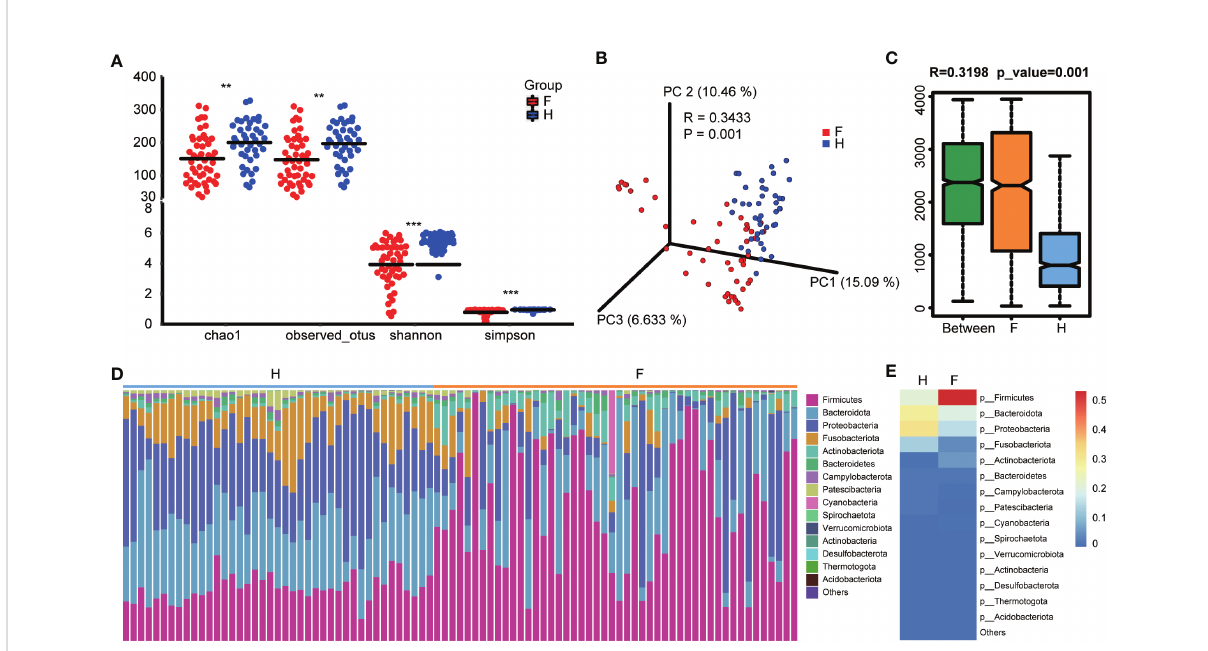
FIGURE 1 Diversity and structural analysis of the oropharyngeal microbiota. (A) Alpha diversity differences between the two groups were observed using the Simpson index, Shannon index, observed species, and chao1. ** p < 0.05; *** p < 0.001; F, IAV pneumonia group (red); H, healthy group (blue). (B) PCoA plot based on the Bray – Curtis distance matrix re fl ects the difference in bacterial structure between the two groups. F, IAV pneumonia group (red); H, healthy group (blue). (C) Through unweighted unifrac analysis of similarity, we discovered that the difference between groups was signi fi cantly greater than within groups. F, IAV pneumonia group (yellow); H, healthy group (blue). (D) Relative abundances of the top 15 phyla in each group. F, IAV pneumonia group (yellow); H, healthy group (blue). (E) The heatmap re fl ects the similarities and differences in phylum composition between the two groups in terms of color gradients. IAV, in fl uenza A